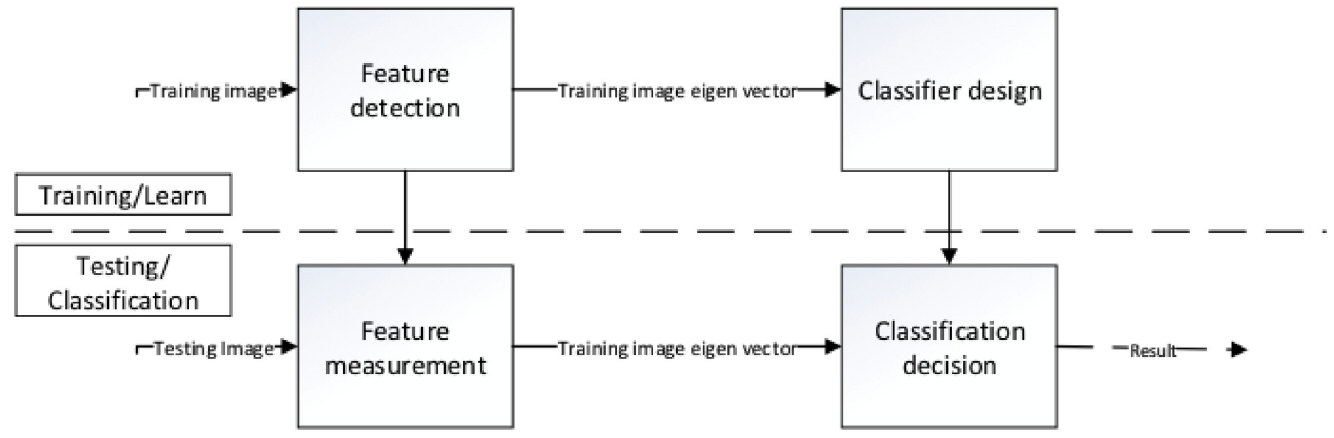
Fig 2. Learning and classification